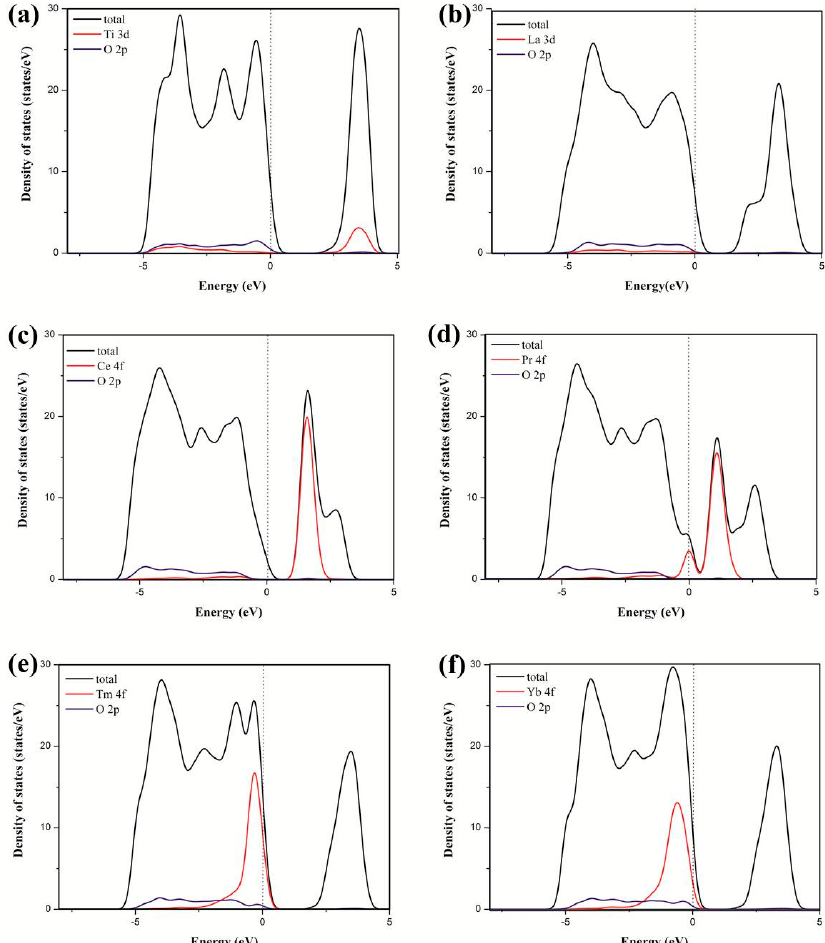
Figure 3. Calculated local partial DOS of the TiO 2 ( a ) and TiO 2 doped by La ( b ), Ce ( c ), Pr ( d ), Tm ( e ), and Yb ( f ). The Fermi levels are set at the zero of energy.